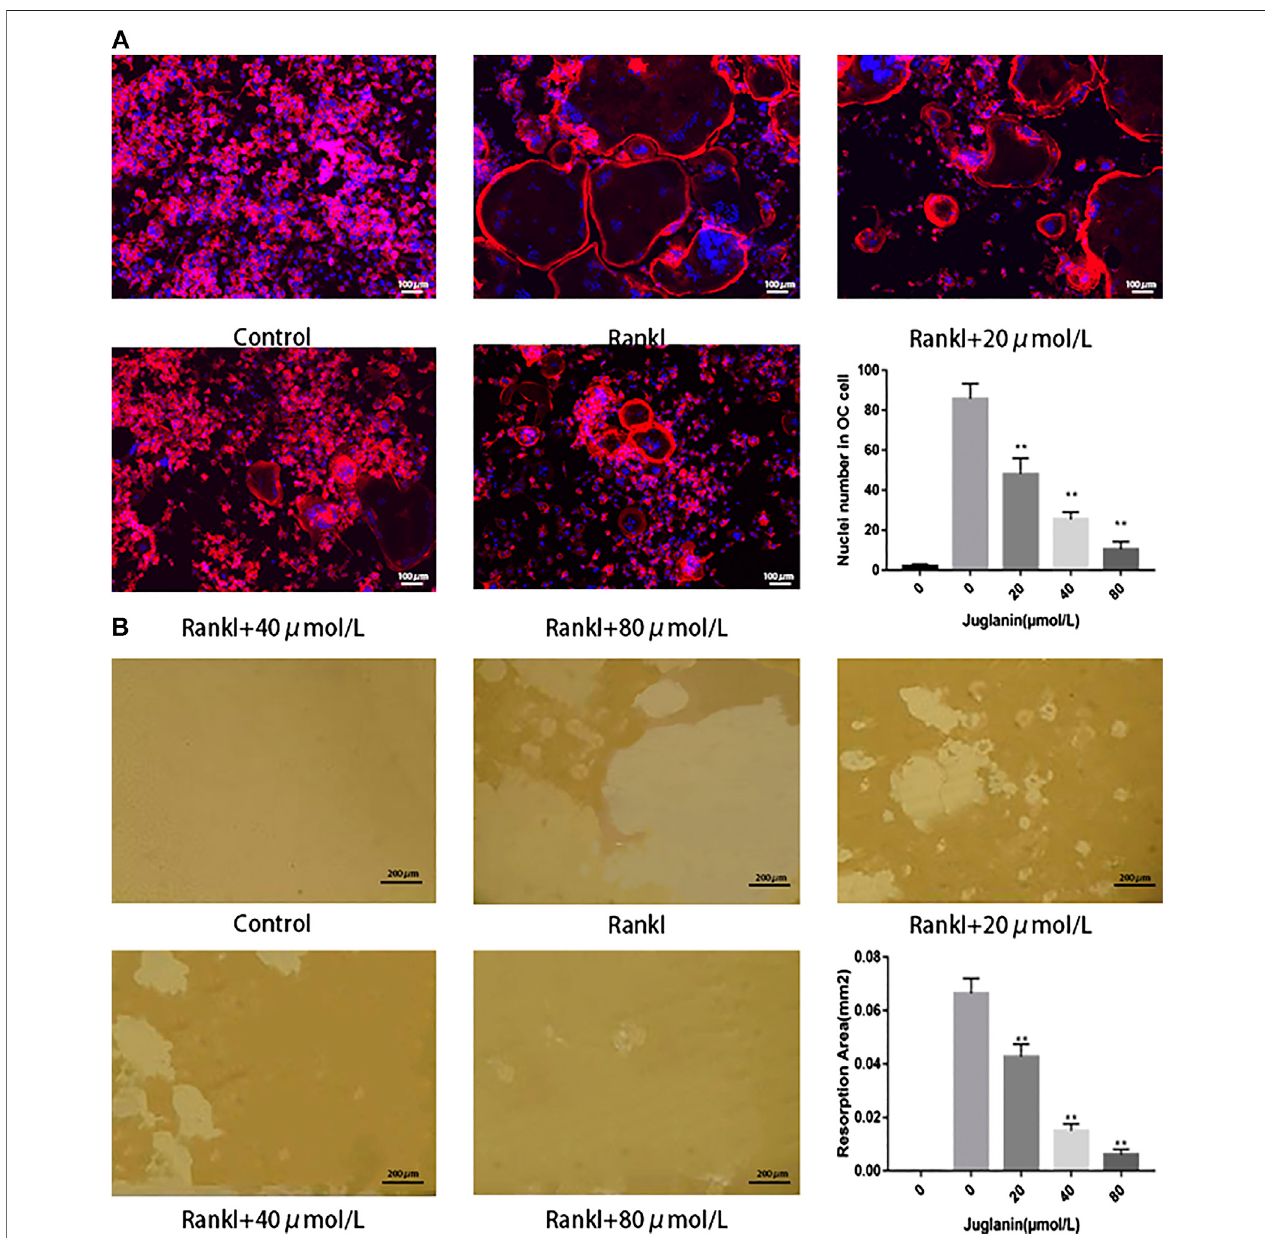
FIGURE2| JUGinhibitsosteoclastsfunction. (A) F-actinstainingofosteoclasts(RANKL-inducedBMMs)andquanti fi cationoftheactinring (B) Pitsformationassayof osteoclasts and quanti fi cation of resorption area. Scale bar 100 μ m. Data are presented as the mean ± SEM, * p < 0.05, ** p < 0.01 relative to the control group. n (cid:2) 3